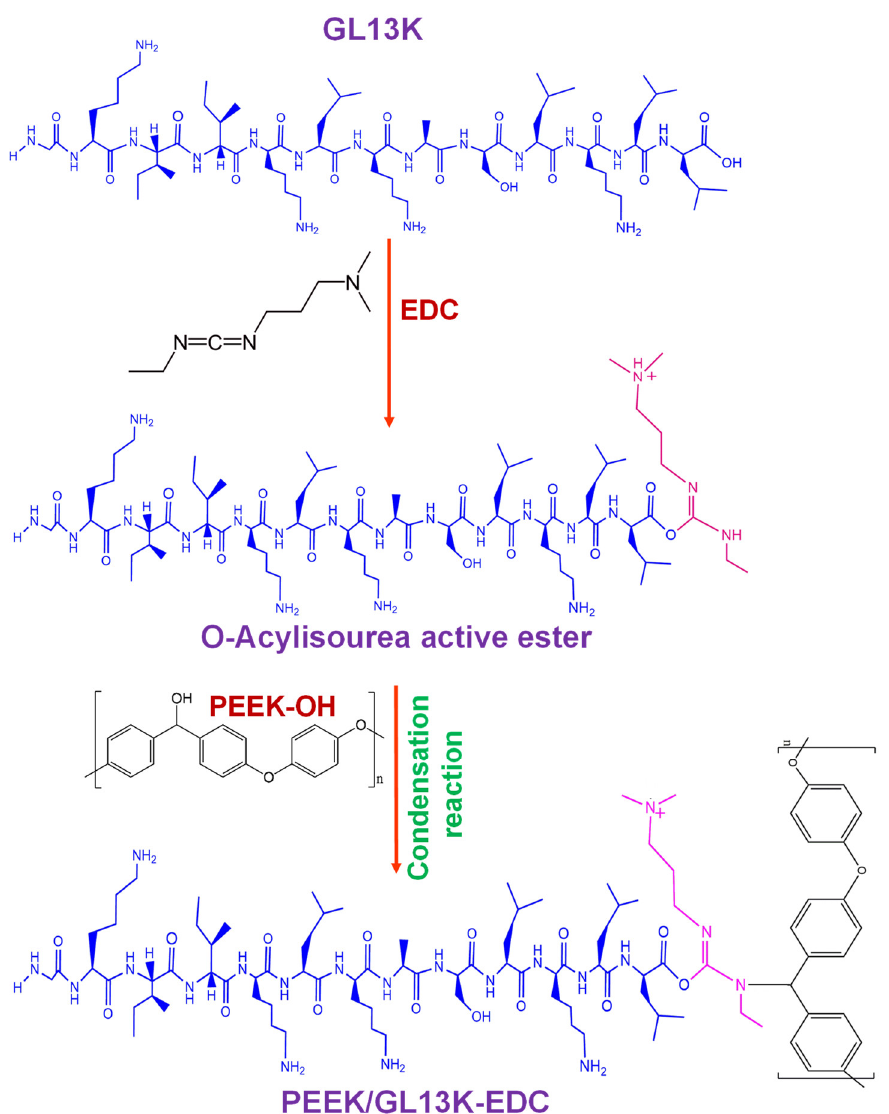
Figure 9. Proposed schematic of the possible chemical attachment of GL13K to the PEEK surface through EDC coupling reactions.